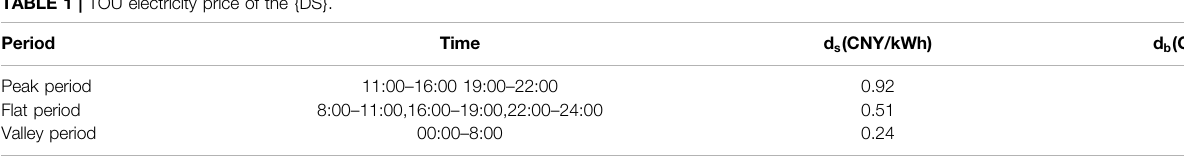
TABLE 1 | TOU electricity price of the {DS}.